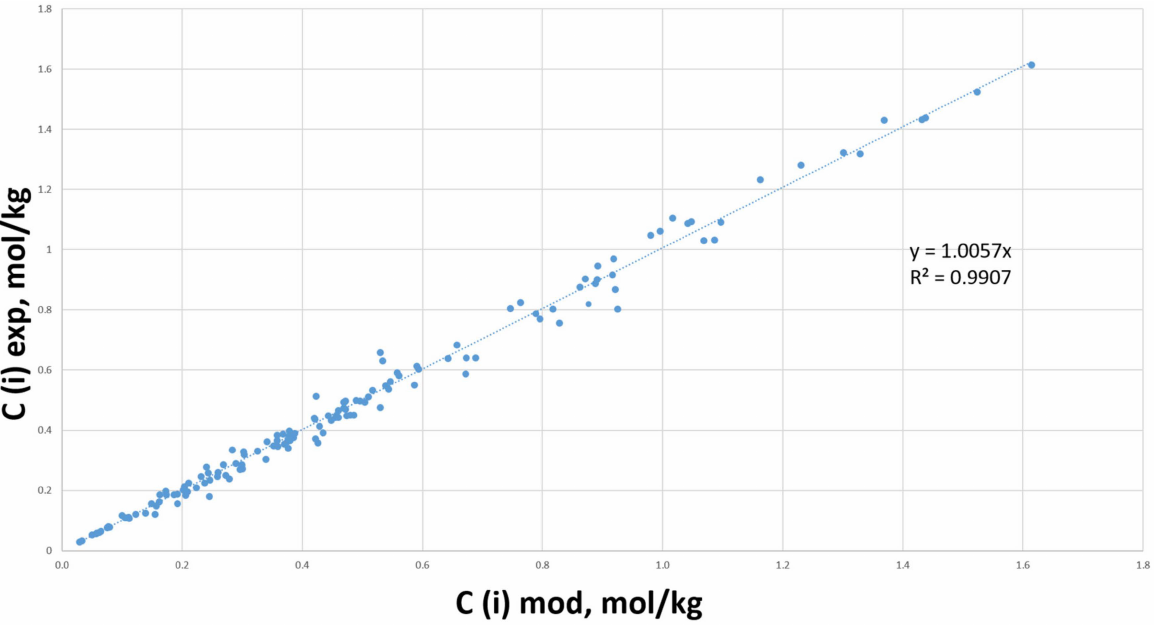
Figure 5. Correlation between the experimental and calculated data: (i) = butyl lactate, lactamide, ammonium lactate + lactic